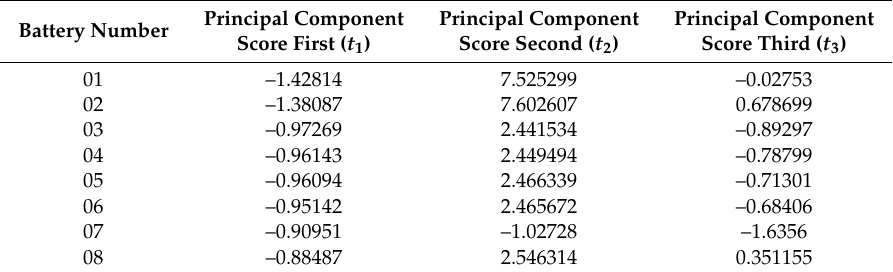
Table 4. Examples of principal component scores for eight batteries (Group 2).